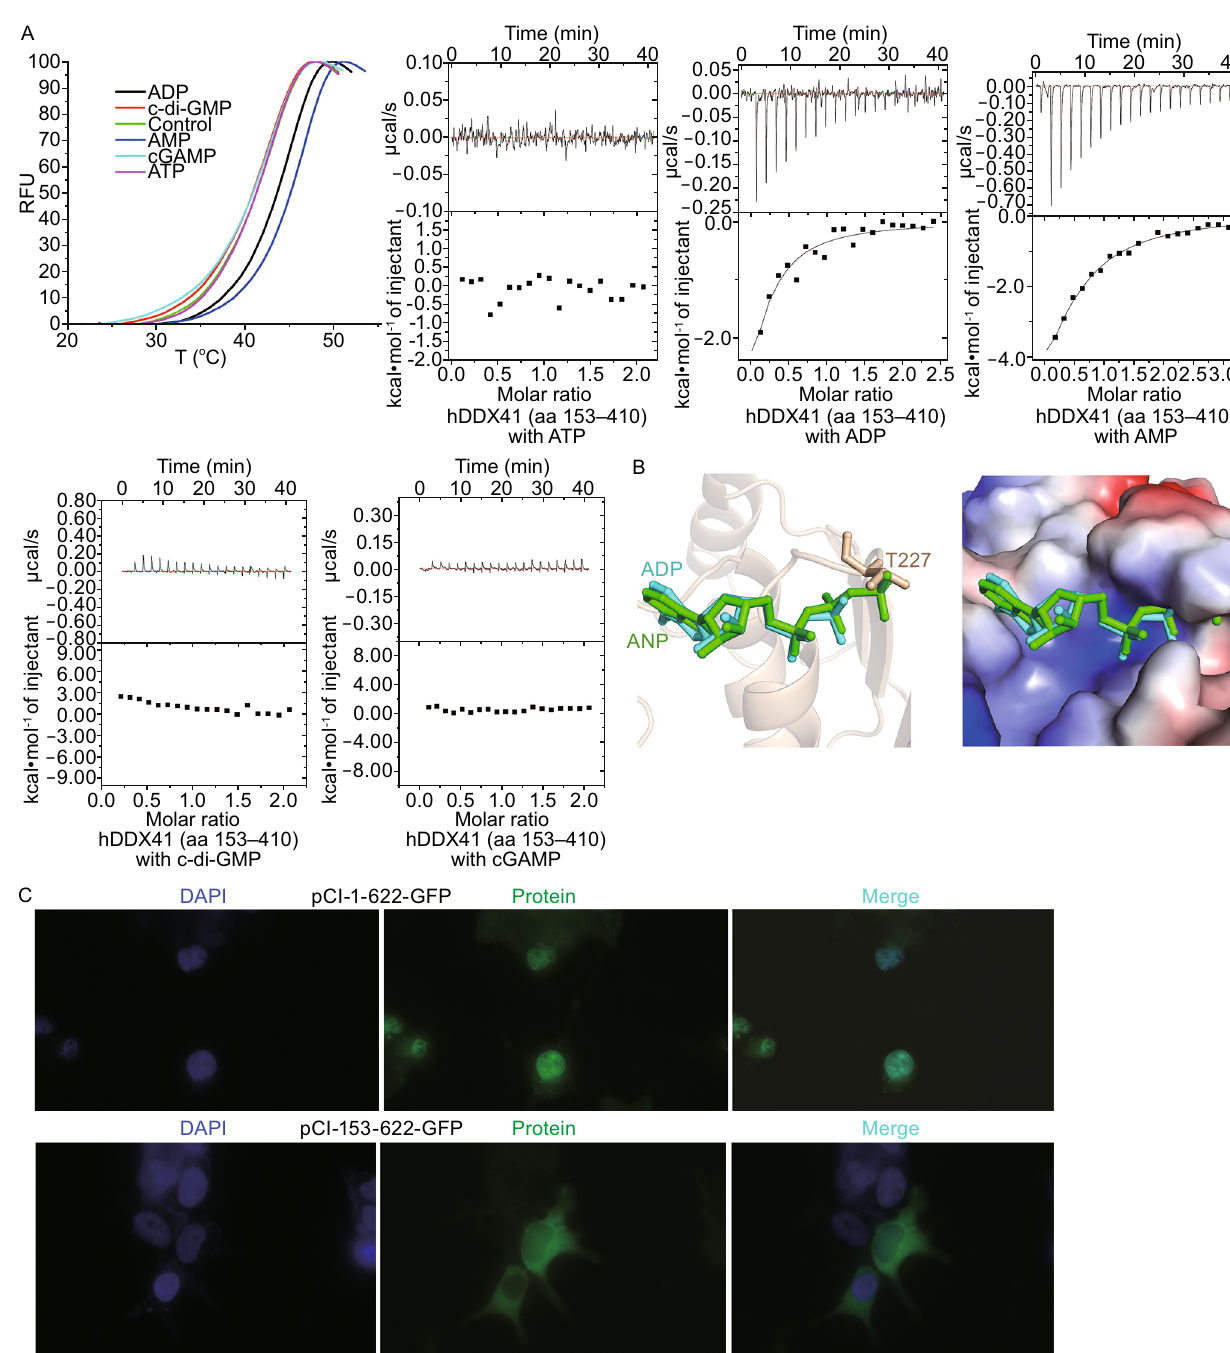
Figure 2. The binding of hDDX41 DEAD domain with different molecules and N-terminal region targets hDDX41 to the nucleus. (A) Thermal Shift Assay and Isothermal Titration Calorimetry of hDDX41 DEAD domain protein with ATP, ADP, AMP, c-di- GMP and cGAMP. (B) Left: the modeled ADP and ANP are colored in cyan and green. The γ -phosphate of ANP clashes with T227 of hDDX41. Right: surface electrostatic potential representation of the nucleotide binding pocket. Blue, positive potential; red, negative potential. The positively charged binding pocket is not big enough for ANP binding. (C) Fluorescence microscopy of HEK293T cells transfected with expression plasmids for GFP-tagged hDDX41 full length protein (1 – 622) and GFP-tagged hDDX41 N-terminal region deleted truncation (153 – 622). Nuclei are stained with